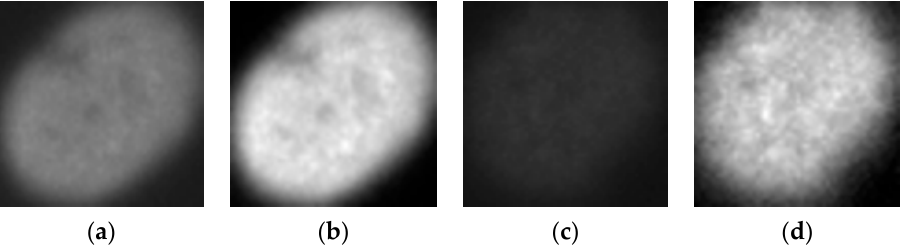
Figure 3. HEp-2 cellular images from the SNPHEp-2 dataset. ( a ) A positive intensity fine speckled cell; ( b ) its approximation coefficients; ( c ) a negative intensity fine speckled cell and ( d ) its approximation coefficients. Note the effective homogenization in terms of gray level intensity between the positive ( b ) and negative ( d ) images.